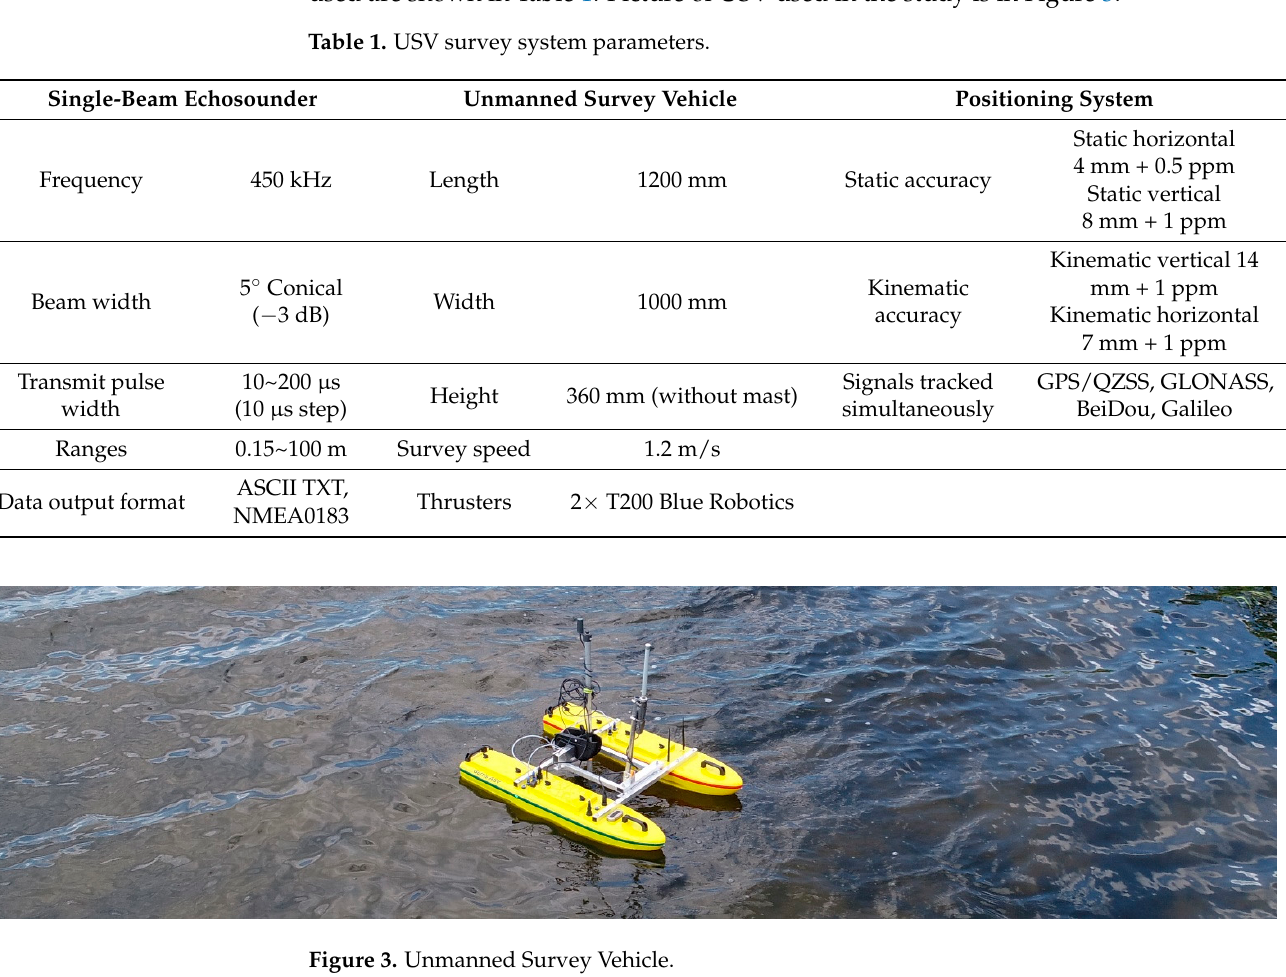
Figure 3. Unmanned Survey Vehicle. Table 1. USV survey system parameters.